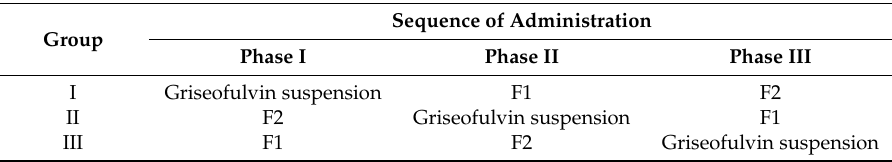
Table 1. Sequence of administration of griseofulvin aqueous suspension, F1 and F2.